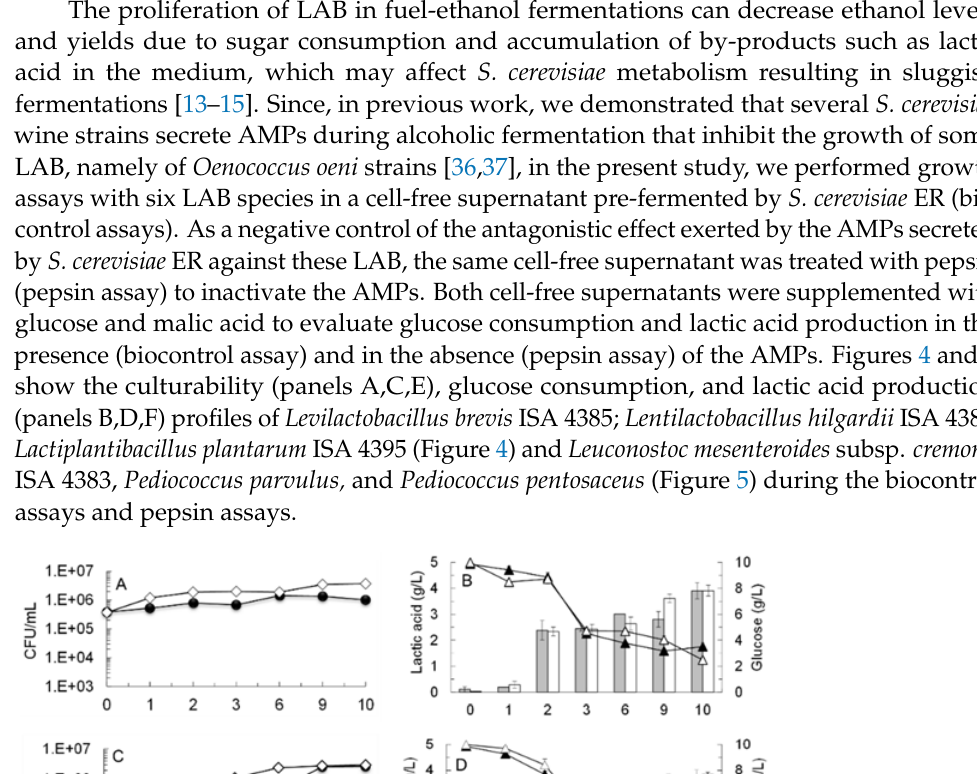
Figure 5. Culturability ( A , C , D ), glucose consumption and lactic acid production ( B , D , F ) during growth assays performed with L. mesenteroides subsp. cremoris ( A , B ), P. parvulus ( C , D ) and P. pentosaceus ( E , F ) inoculated in a cell ‐ free supernatant pre ‐ fermented by S. cerevisiae ER without any treatment (biocontrol assay) and after a pepsin treatment (pepsin assay). Data represented correspond to means ± SD (error bars) of two independent biological assays. Results (Figures 4 and 5) show growth inhibition (panels A ,C, E) of all LAB, except for L. brevis , in the biocontrol assays by comparison with their